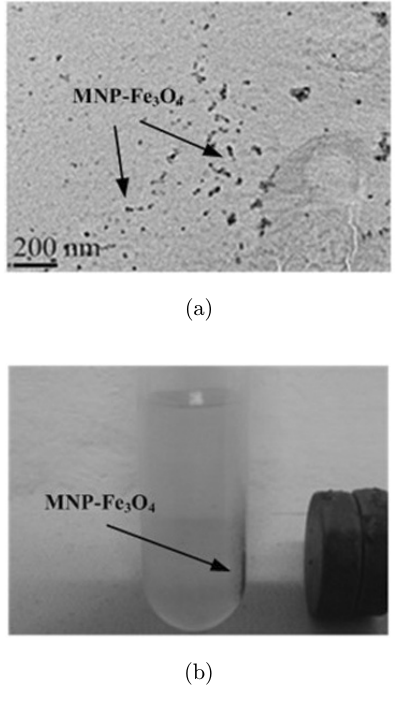
Fig. 2. TEM image of MNP – Fe 3 O 4 (a) and Magnetic at- traction of MNP – Fe 3 O 4 (b).